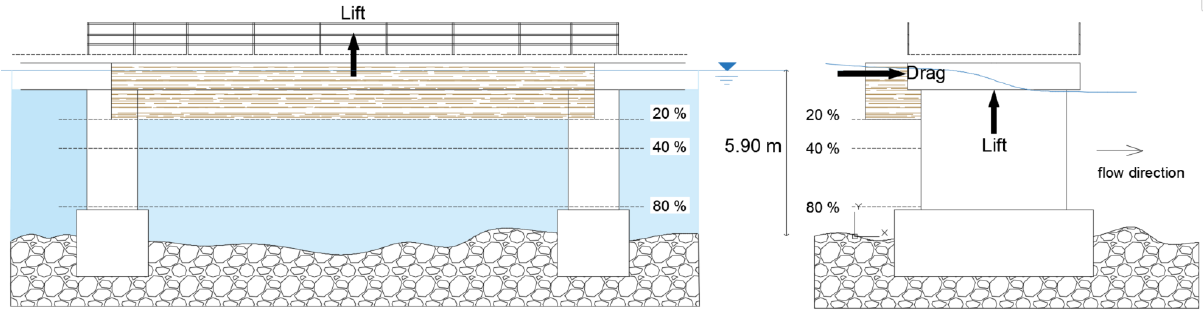
Figure 5. Front and lateral views of partial occlusions (20, 40, and 80%) of one span caused by debris accumulation. Black arrows represent the drag and lift forces acting on the deck.